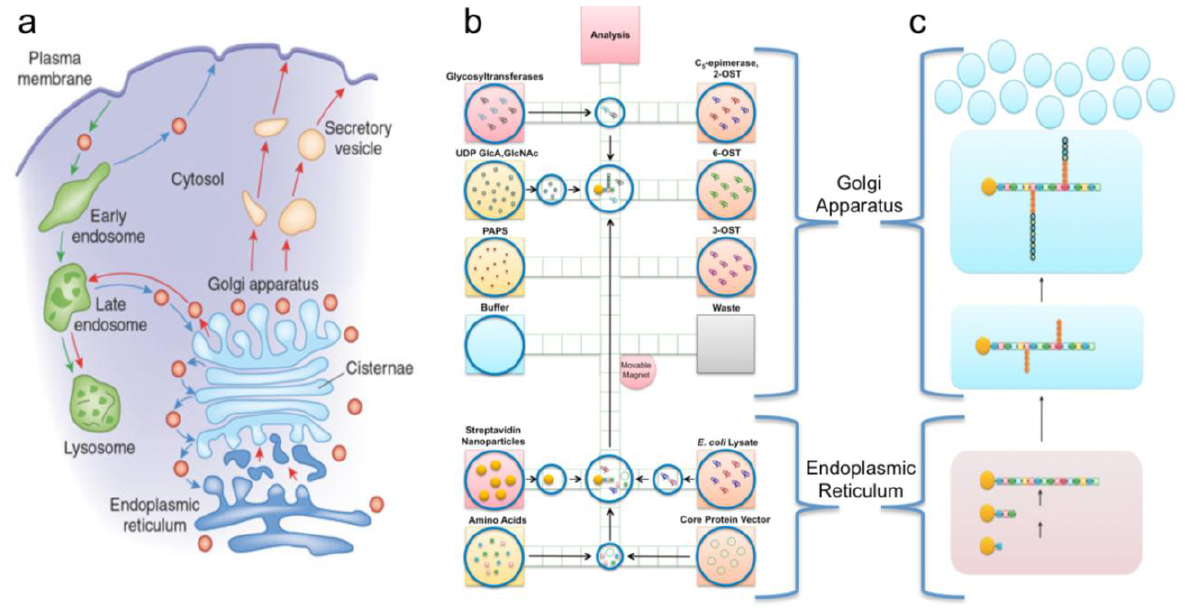
FIGURE 1 . An artificial Golgi and artificial ER are inspired from their natural counterparts. (a) A cartoon depicting the Golgi and ER of a eukaryotic cell. Proteins are synthesized in the ER, and then sent to the Golgi for post-translational modification resulting in glycoprotein and PG products. Modified from Xu et al.[8]. (b) The design of an artificial Golgi/ER digital microfluidic chip for the biosynthesis of the HS-PG is shown. The HS-PG core protein is first synthesized on a magnetic nanoparticle in the artificial ER by in vitro translation. The particle holding the core protein is then transferred into the artificial Golgi portion of the digital microfluidic chip where it is glycosylated to yield HS-PG. The large boxes (multicolor) are reagents and enzyme reservoir electrodes, and the small boxes (light green) are electrodes for droplet movement, mixing, and sequestration. Modified from Martin et al.[7]. (c) A cartoon depicting the process of in vitro translation and glycosylation in the artificial ER/Golgi